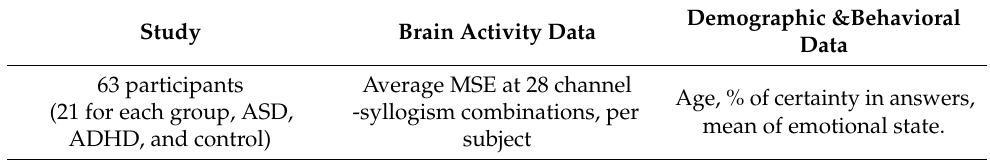
Table 3. Data used in the study for both valid and invalid